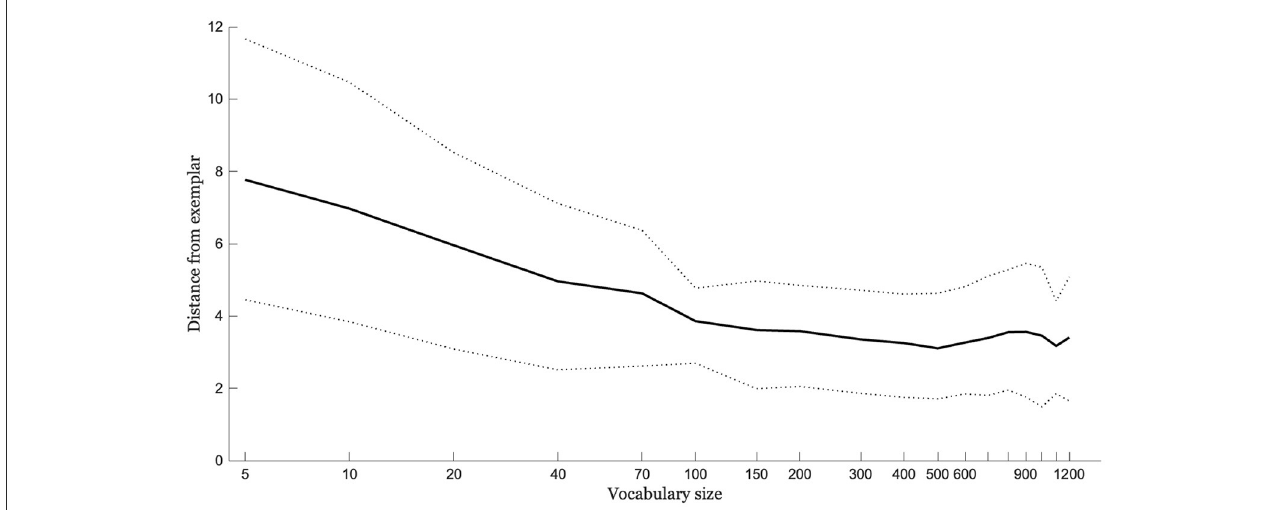
FIGURE11 The average distance of the output trajectory from a novel word exemplar given integration based on an A-silhouette built from the 3 perceptually-closest silhouettes to the novel word exemplar. Distances are shown as a function of vocabulary size (log-transformed). Dotted lines show ± 1 standard deviation around the mean for the simulation, which was run 20